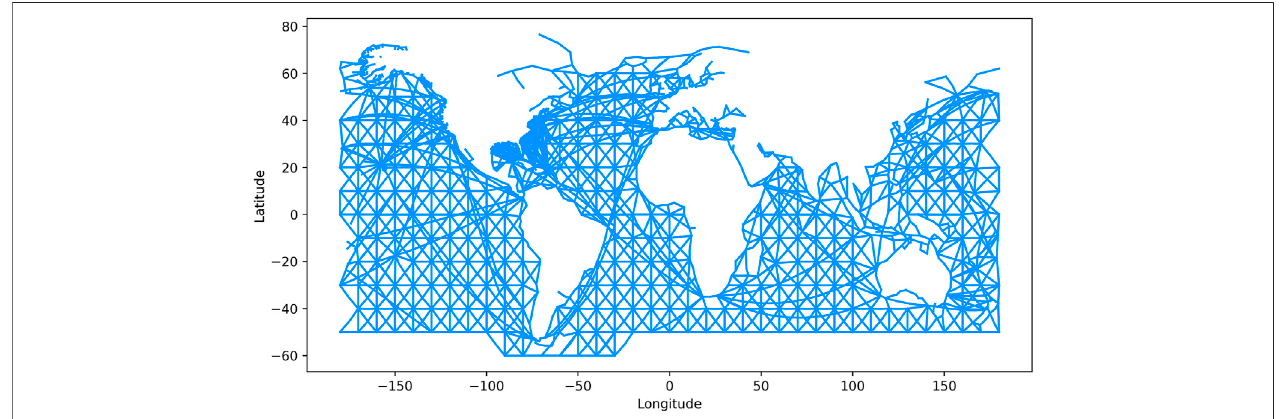
FIGURE 3 | Global network of shipping routes created from AIS data, used to evaluate the shortest shipping distance between ports.